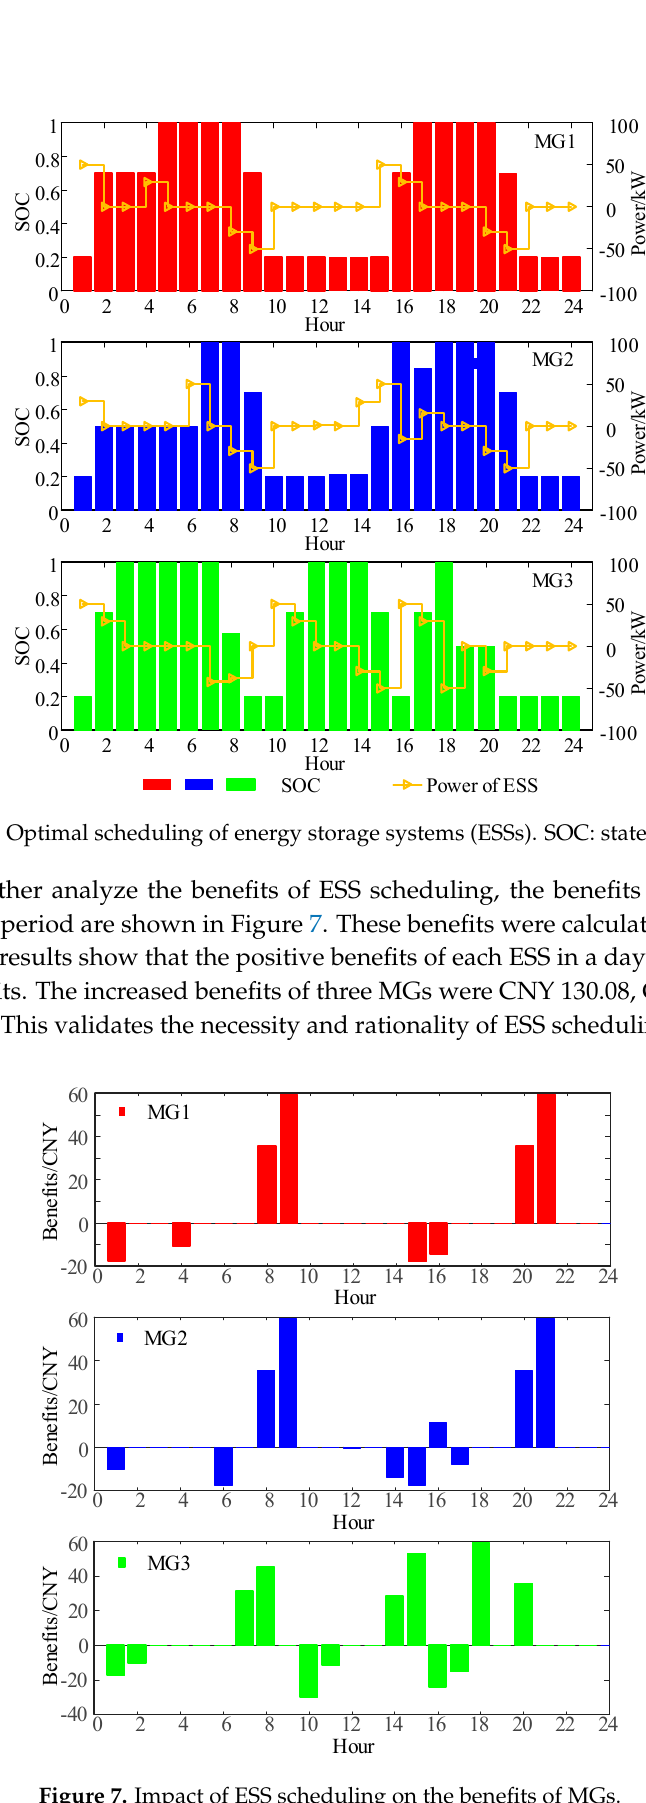
Figure 7. Impact of ESS scheduling on the benefits of